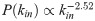
The degree distributions of the Japanese supplier-customer network.Both, the in and out degree distributions show scale-free behavior, with the respective power-law indexes P(kin)∝kin-2.52 and P(kout)∝kout-3.26.